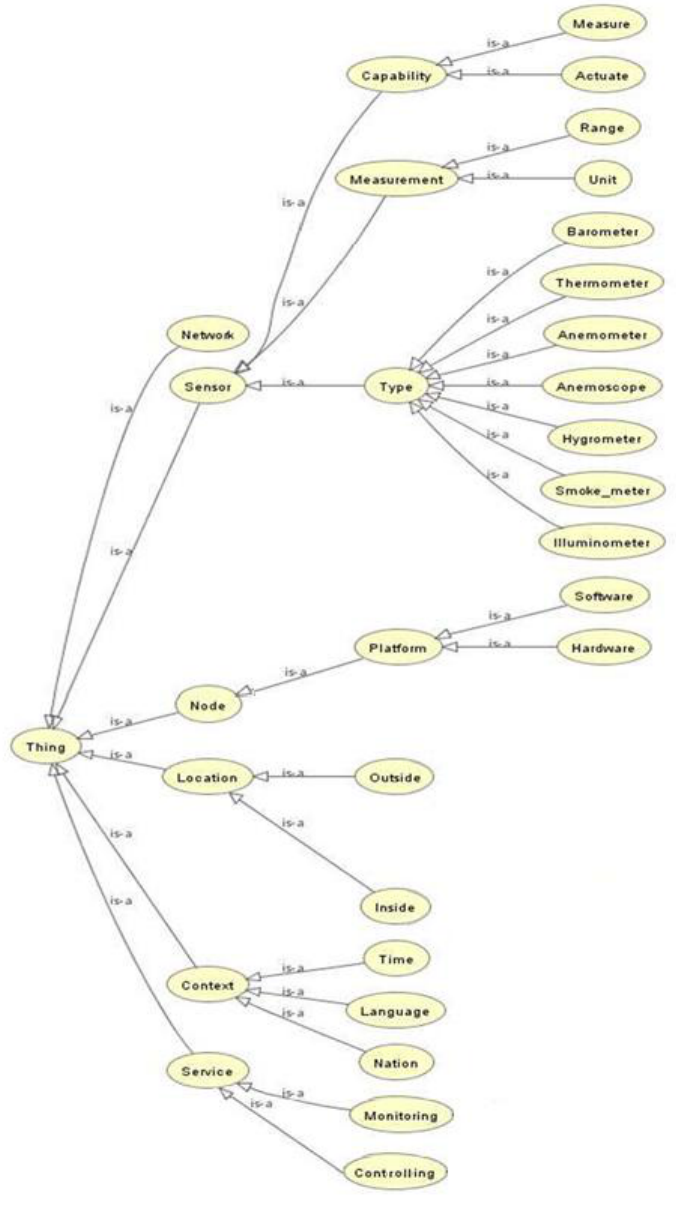
Figure 15. Class hierarchies of